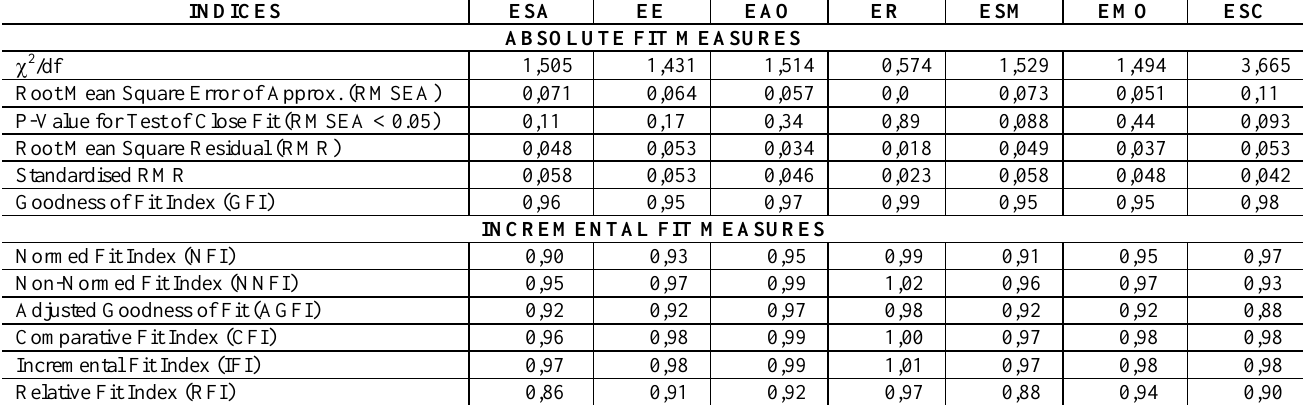
Table 2: Confirmatory factor analysis fit indices obtained for the refined GENOS EI measurement models INDICES